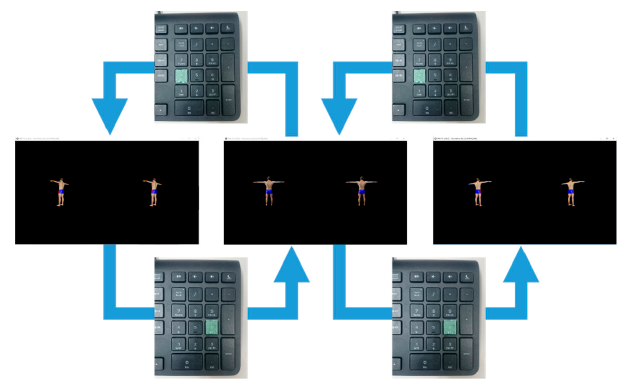
Figure 2. Key-switched virtual stereo Rearview (KSR): In the case of pressing the “6-key”, the displayed stereo-view pair is switched from the present stereo-view pair to the other stereo-view pair rotated by 45° in the counterclockwise direction. In the other case of pressing the “4-key”, it is switched from the present to the other stereo-view rotated by 45° in the clockwise direction.